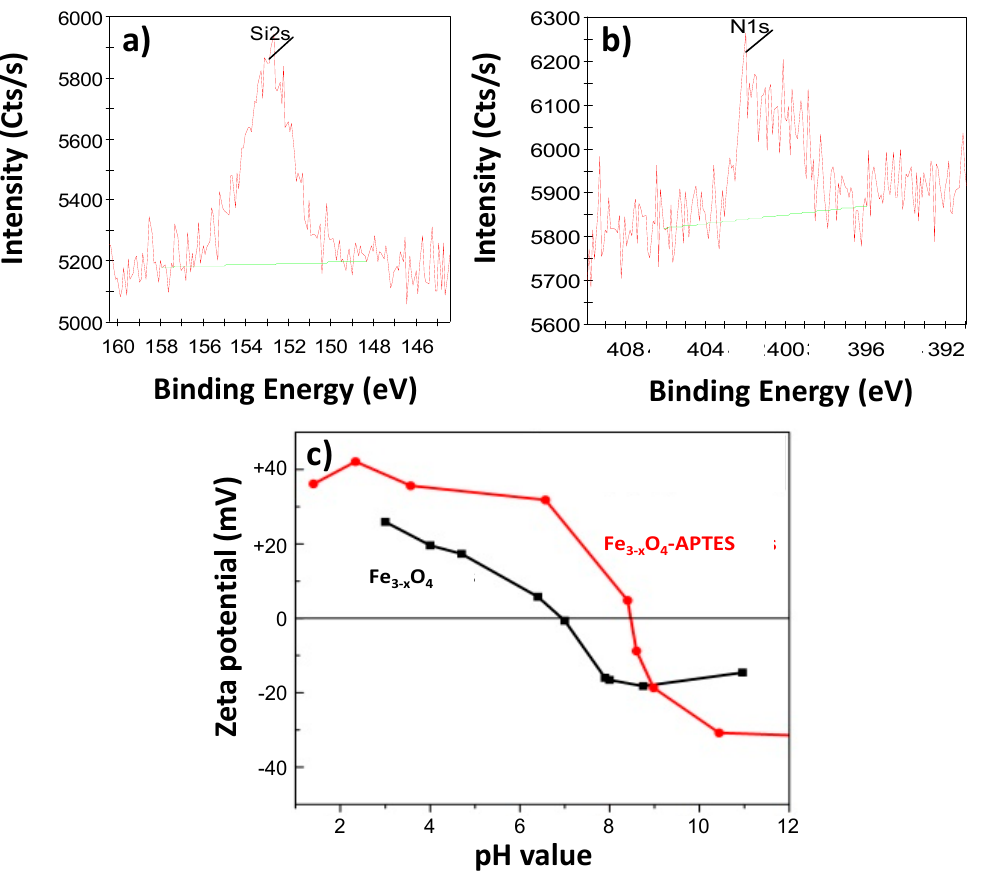
Figure 3. High resolution XPS spectra of ( a ) Si 2s (153 eV) and ( b ) N 1s signals (402 eV characteristic of protonated N) recorded on APTES grafted iron oxide particles, evidencing the signature of silane and ammonium species on the surface of the analyzed particles. ( c ) Zeta potential as a function of the pH measured on bare particles (isoelectric point (IEP) = 6.9) and the grafted to APTES ones (IEP = 8.9). The continuous line (red or black) is just a guide for the eye.